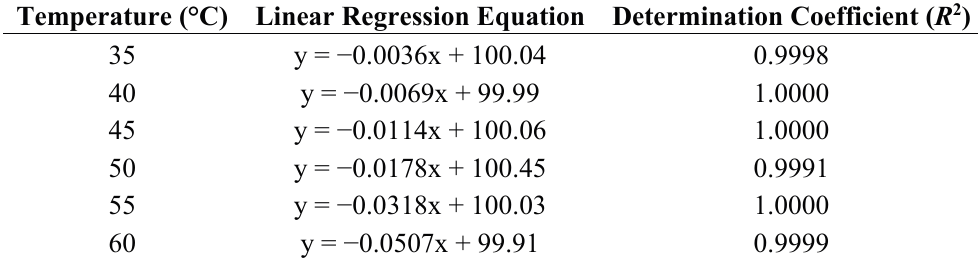
Table 1. Regression parameters obtained from the curves’ G-0 weight loss versus time at each temperature.